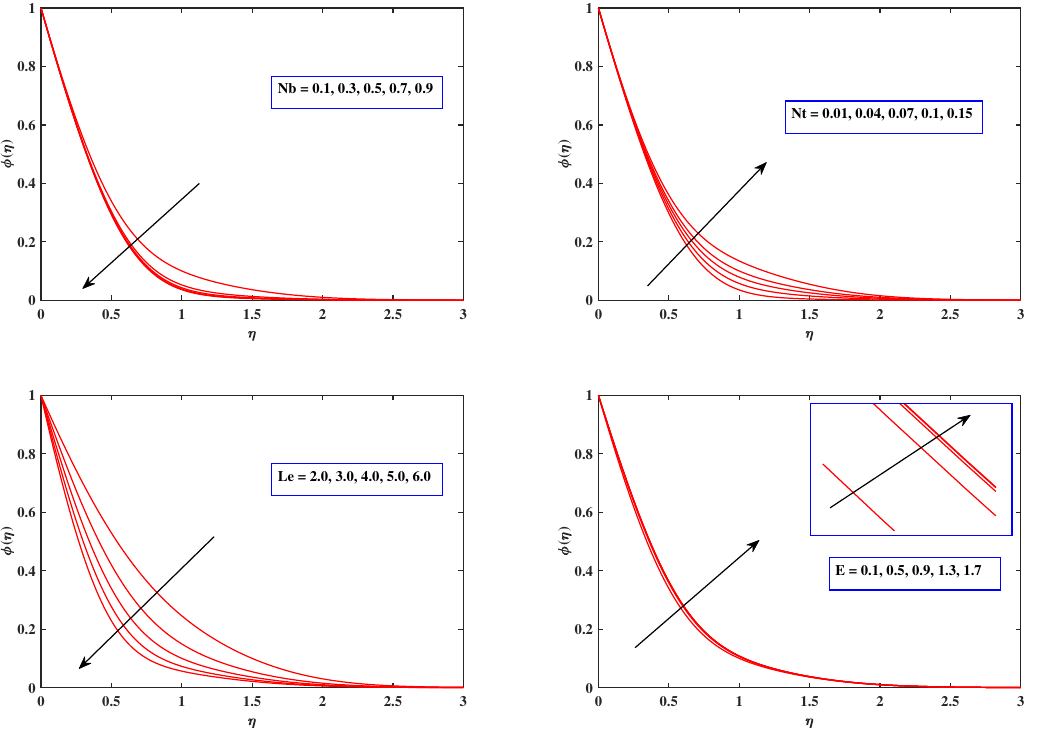
Figure 7. Fluctuation in concentration profile with Nb , Nt , Le and E .